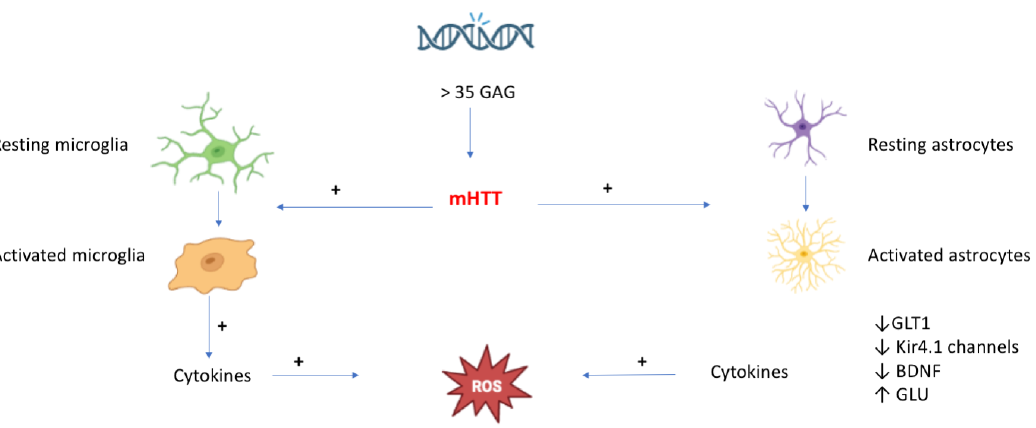
Figure 1. The consequence of the toxic protein mHTT synthesis in the HD (created in BioRen- der.com).